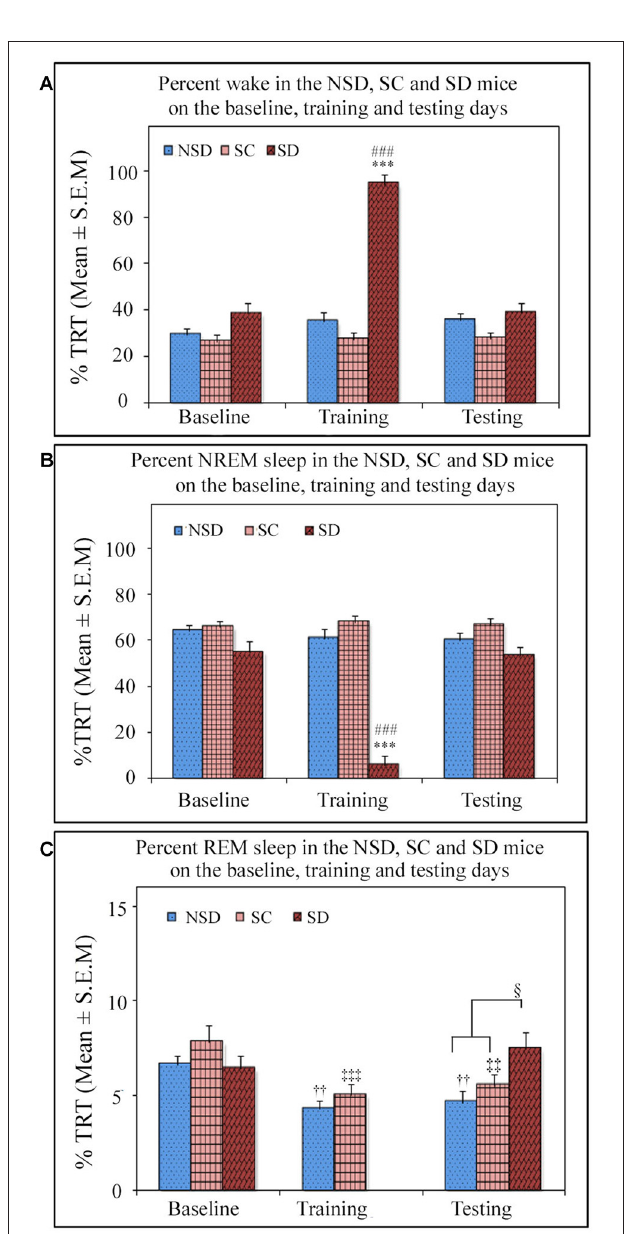
FIGURE 6 | The comparative changes in percent amount of wake, NREM and REM sleep (out of total recording time (TRT)) after contextual fear conditioning in the NSD, SC and SD mice on the baseline, training and testing days. (A) The percent wake amount was comparable between groups on the baseline, training and testing days except on the training day in the SD mice. The SD mice were SD on the training day, and they were almost 94% time awake during the deprivation period ( p < 0.001, F ( 2,14 ) = 91.645; compared to NSD (Tukey p < 0.001) and SC (Tukey p < 0.001) animals). (B) The percent NREM sleep amount was also comparable between groups except on the training day in the SD mice. The SD animals exhibited significantly less (6%) NREM sleep ( p < 0.001, F ( 2,14 ) = 80.436; compared to NSD (Tukey p < 0.001) and SC (Tukey p < 0.001) animals) during the sleep-deprivation period. (C) The percent REM sleep was comparable between groups on the baseline day. However, REM sleep significantly decreased on the training and testing days in the NSD and SC mice (in NSD mice: the training day ( Continued